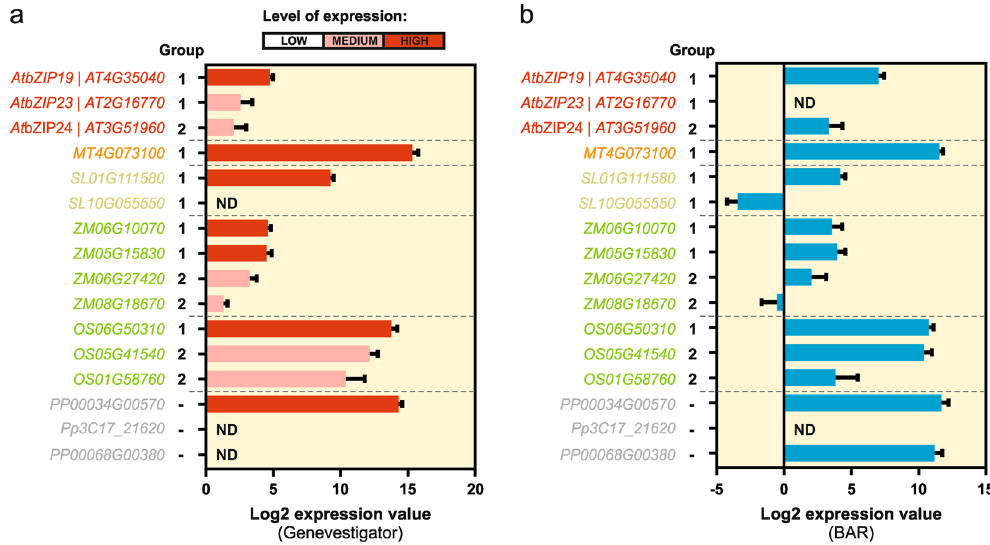
Figure 4. Plant F-bZIP gene expression levels. ( a ) The expression level of each F-bZIP gene along the plant development of each species was retrieved from the Genevestigator database as Log2 of the expression value. The bar on top of the graphic indicates Genevestigator’s classification of expression values as Low, Medium or High, based on quartile expression analysis across all genes. ( b ) The absolute expression values along plant development were downloaded from the BAR database and mean of Log2 calculated. Error bars represent standard deviation (n > 5). ND stands for No